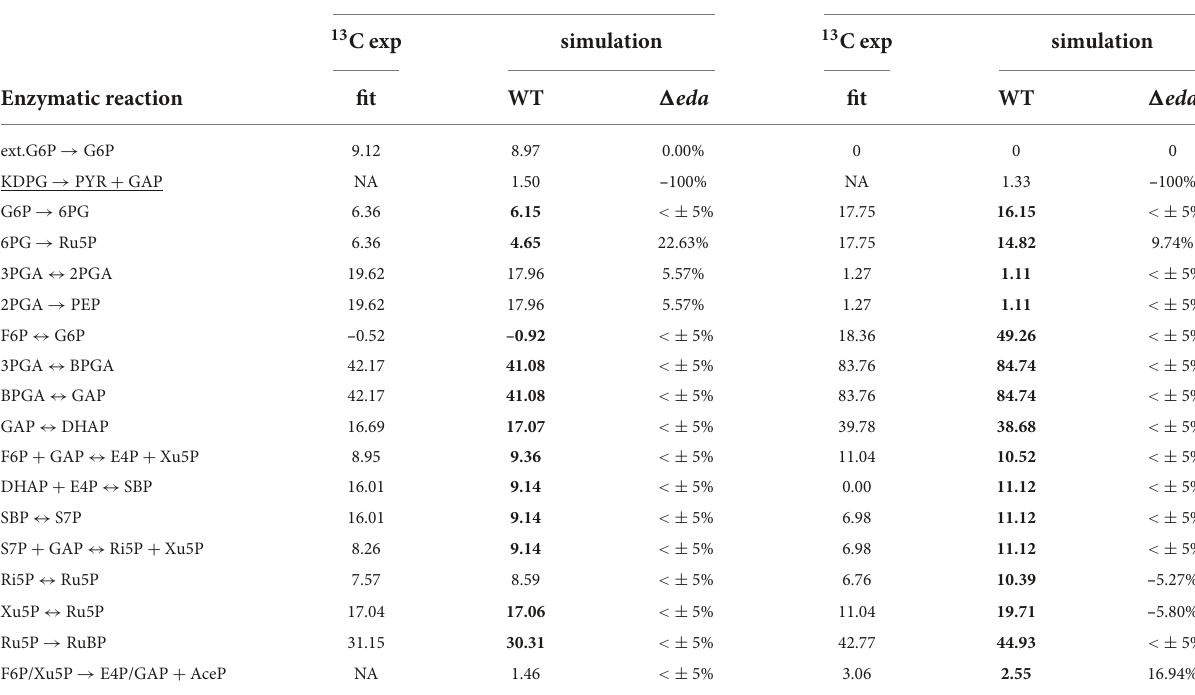
TABLE 4 Comparison of experimental and simulated metabolic fluxes.